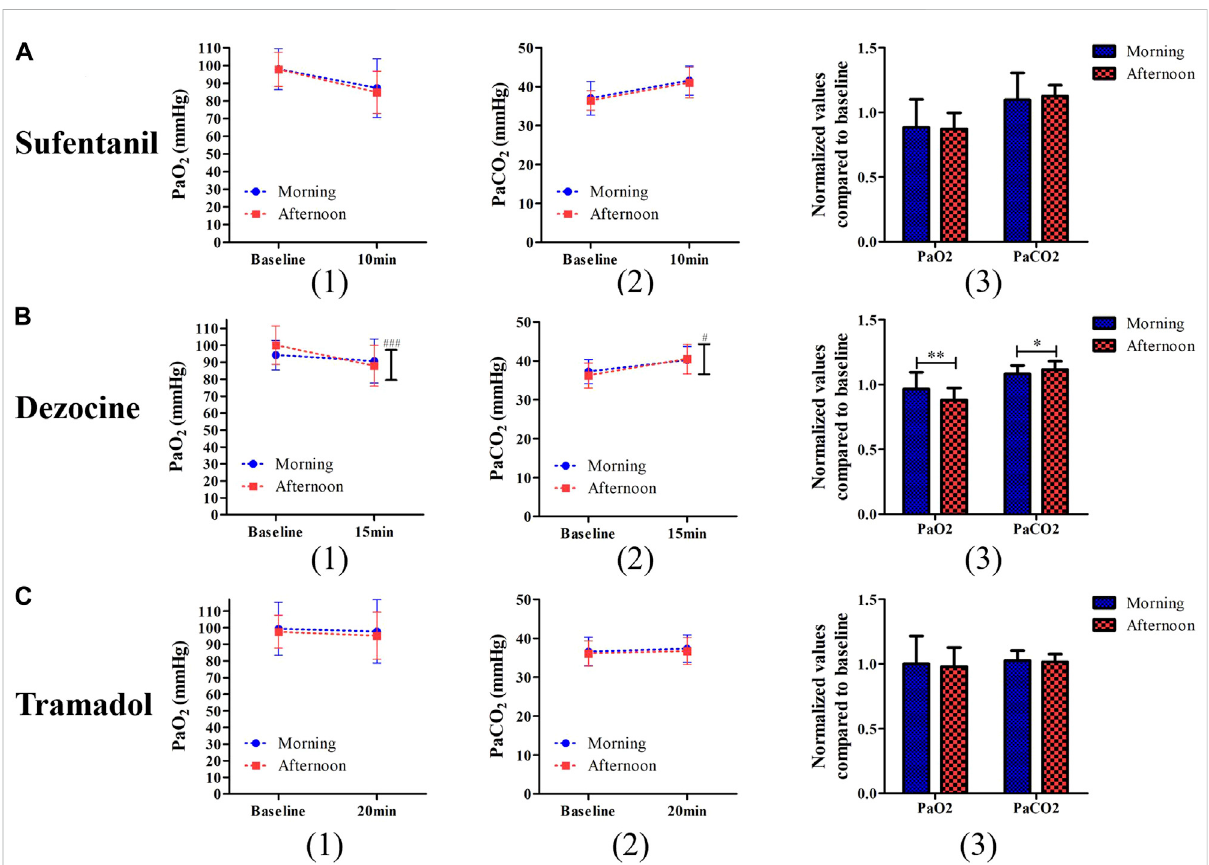
FIGURE 4 Comparisons of PaO 2 (1) and PaCO 2 (2) and their changed levels (3) after test procedure between the morning group and afternoon group for patients receiving sufentanil treatment (A) , dezocine treatment (B) and tramadol treatment (C) . (* p < 0.05 and ** p < 0.01 compared with the afternoon group; # p < 0.05 and ### p < 0.001 represents the time and group effects for two way repeat analysis of